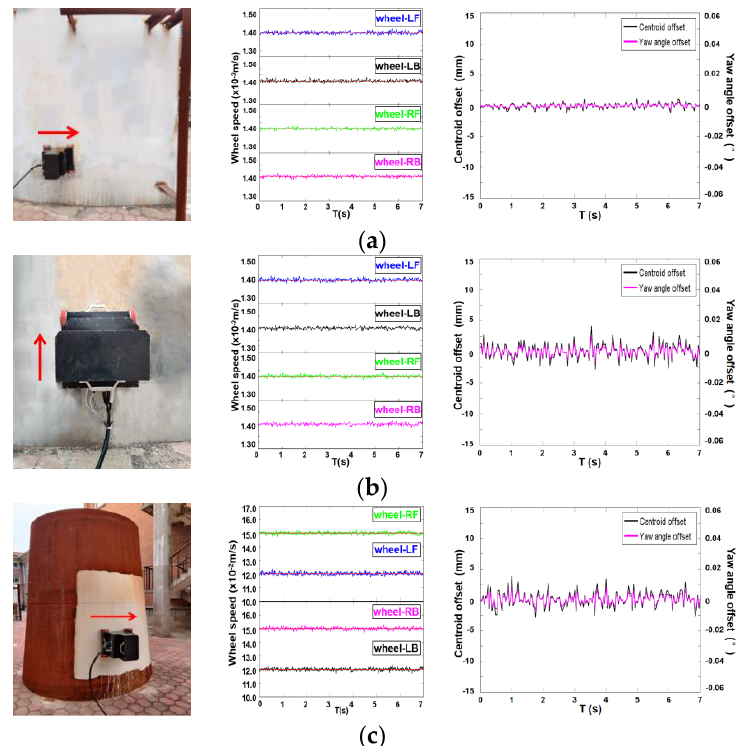
Figure 11. Sports performance test. ( a ) Horizontal circular motion on a circular steel plate; ( b ) vertical upward motion on a circular steel plate; ( c ) horizontal circular motion on a circular steel plate with variable curvature.